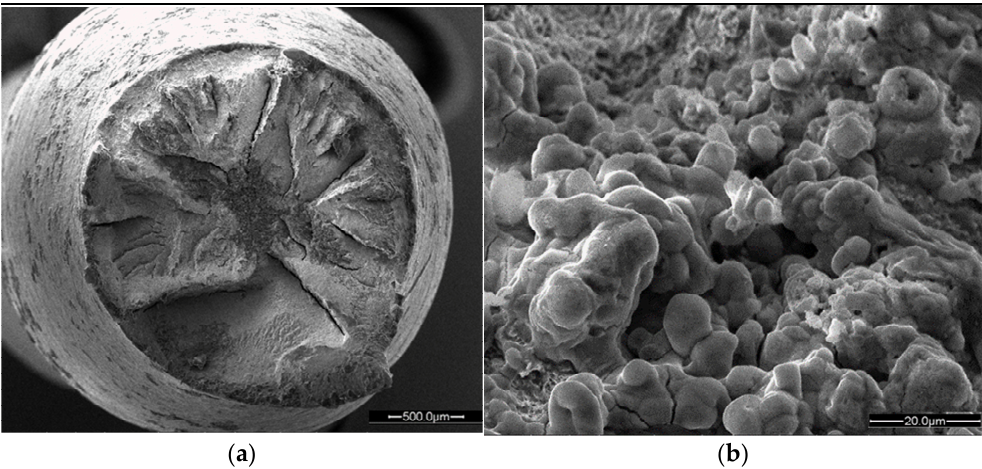
Figure 6. ( a ) SEM fracture surface area of SSR sample tested in N 2 ; ( b ) SEM image of the surface of SSR sample tested in N 2.